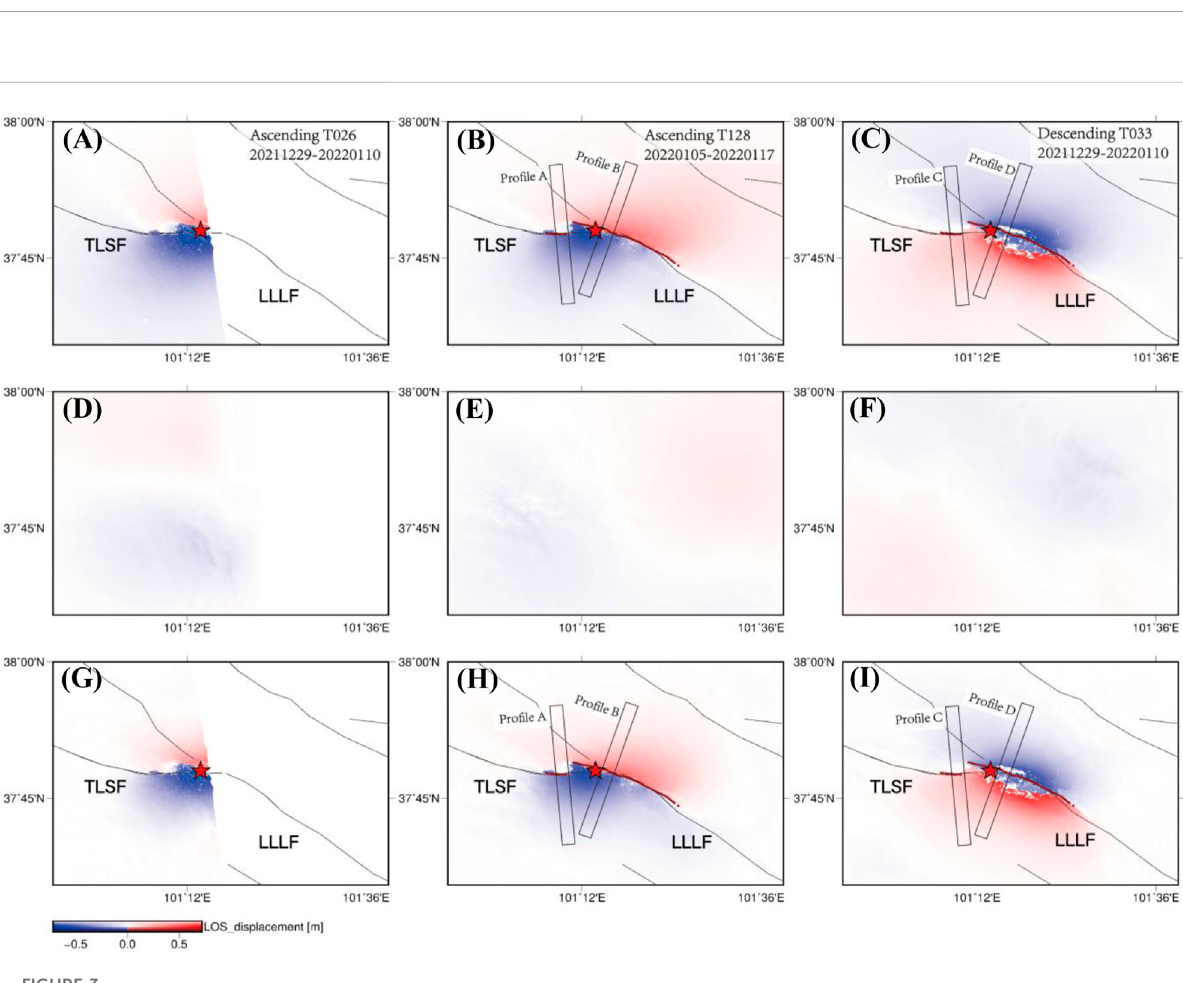
FIGURE 3 Atmosphericcorrectionfortheascendinganddescendingdata. (A – C) LOSdisplacementmapsbeforeatmosphericcorrection. (D – F) Strati fi ed tropospheric delay, estimated using the SSC method. (G – I) After atmospheric correction. The epicenter is indicated by a red star, and the dark-red line indicates the fi eld-investigated surface rupture from Pan et al.